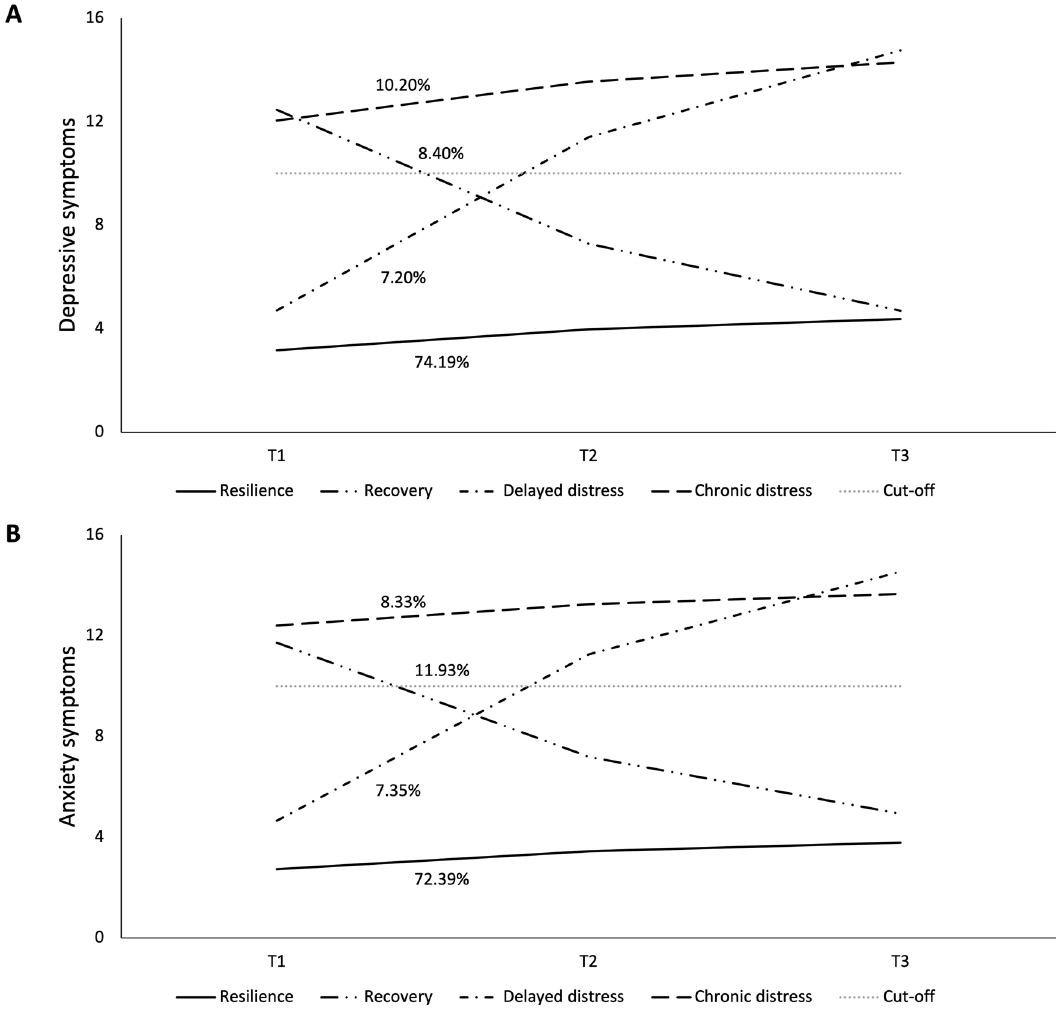
Fig. 1 Trajectories of depressive and anxiety symptoms. Note. Probable depression was indicated by a score of 10 or above on the 9-item Patient Health Questionnaire (PHQ-9); probable anxiety was indicated by a score of 10 or above on the 7-item Generalized Anxiety Disorder scale (GAD-7). Table 2. Distribution of respondents showing different combinations of depressive and anxiety symptom